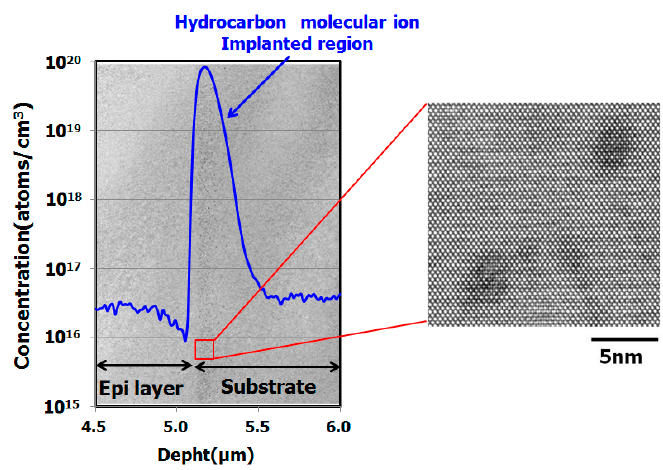
Figure 14. Cross-sectional TEM observation and SIMS depth profile of carbon in hydrocarbon–